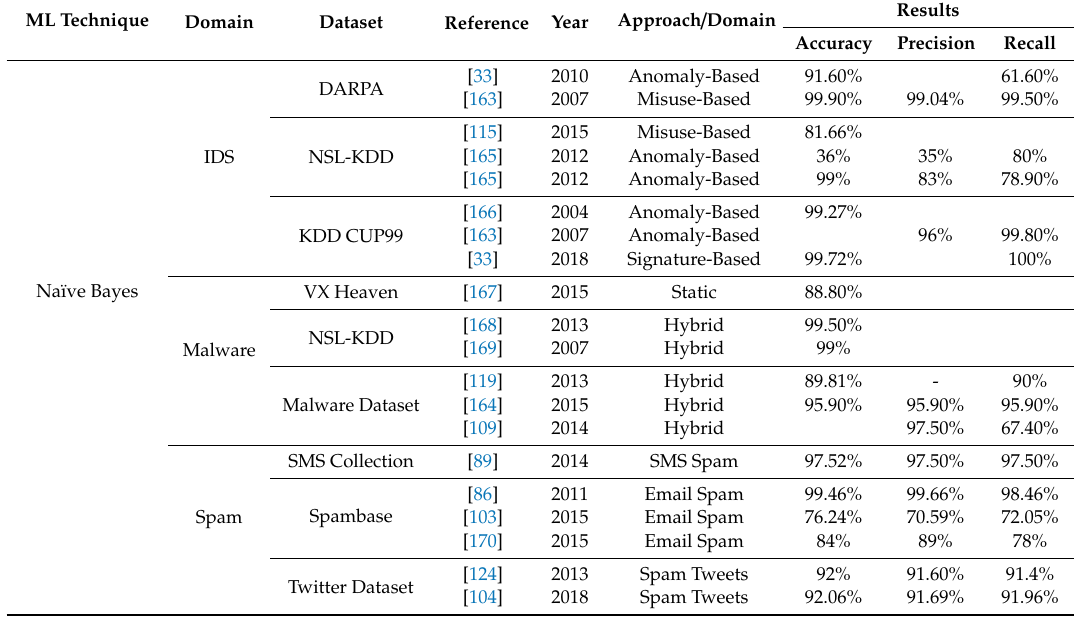
Table 9. Evaluation of Naïve Bayes in